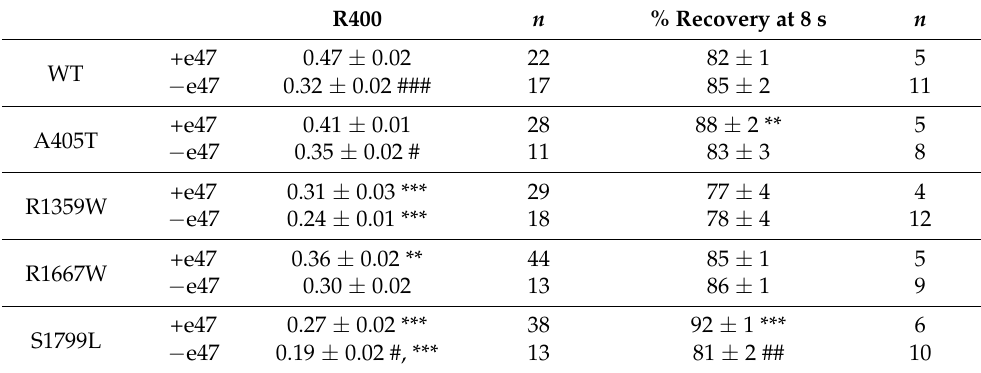
Table 2. Inactivation kinetics and recovery from inactivation.